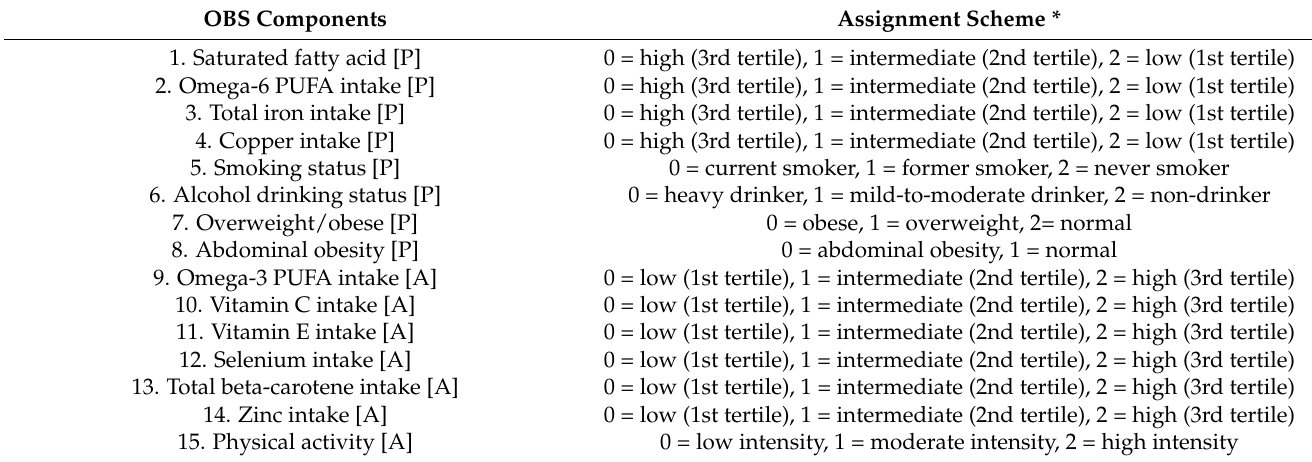
Table 1. Oxidative balance score assignment